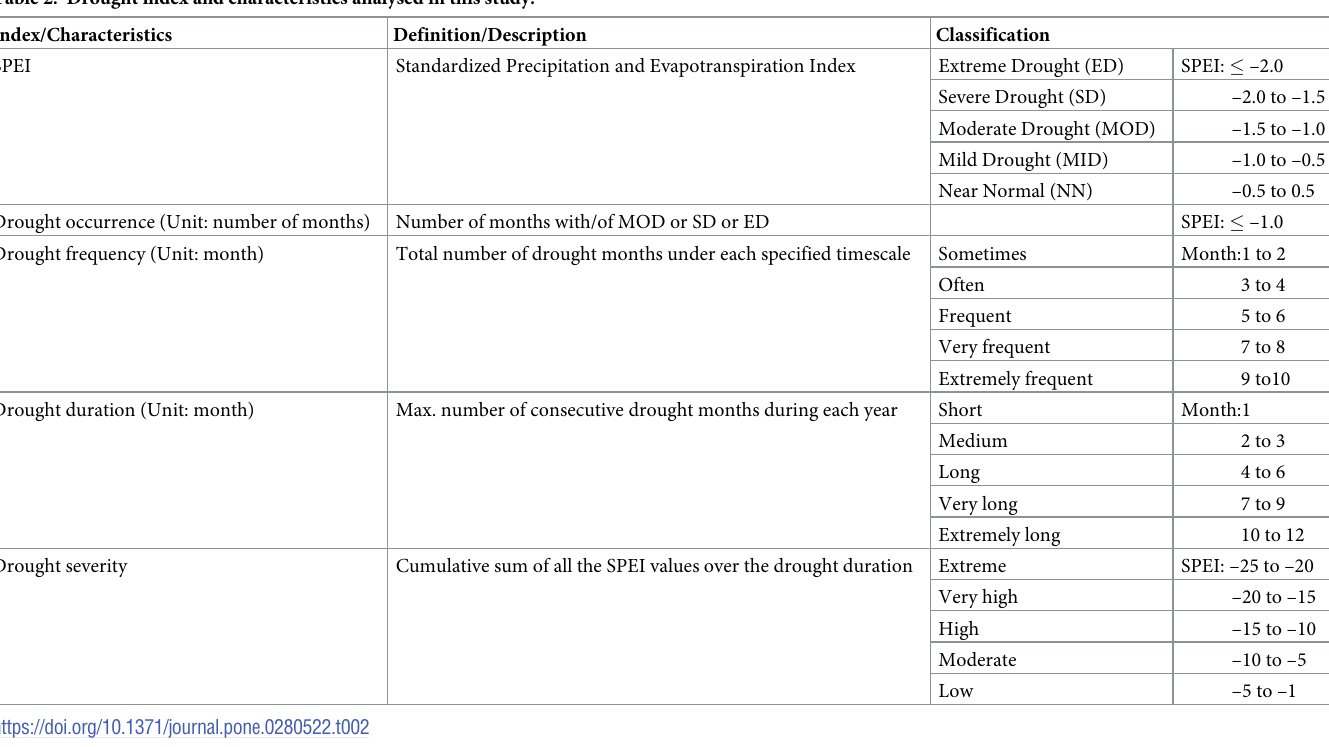
Table 2. Drought index and characteristics analysed in this